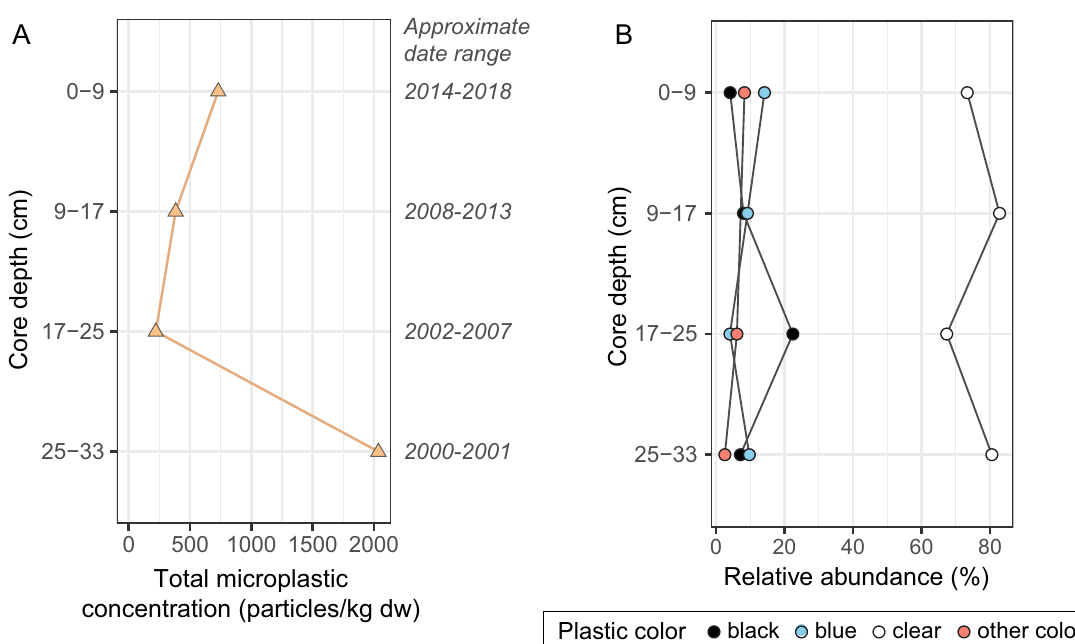
Fig 5. Concentrations of different microplastic types (A) and relative abundance of microplastic colors (B) in sediment core samples from Las Vegas Bay, Lake Mead, 2018. dw, dry weight.